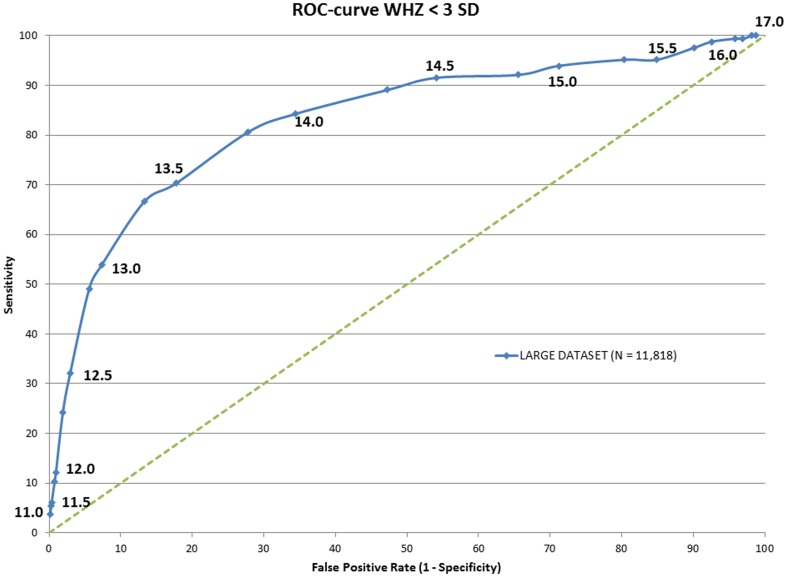
ROC curve of the MUAC score in against WHZ<-3SD.